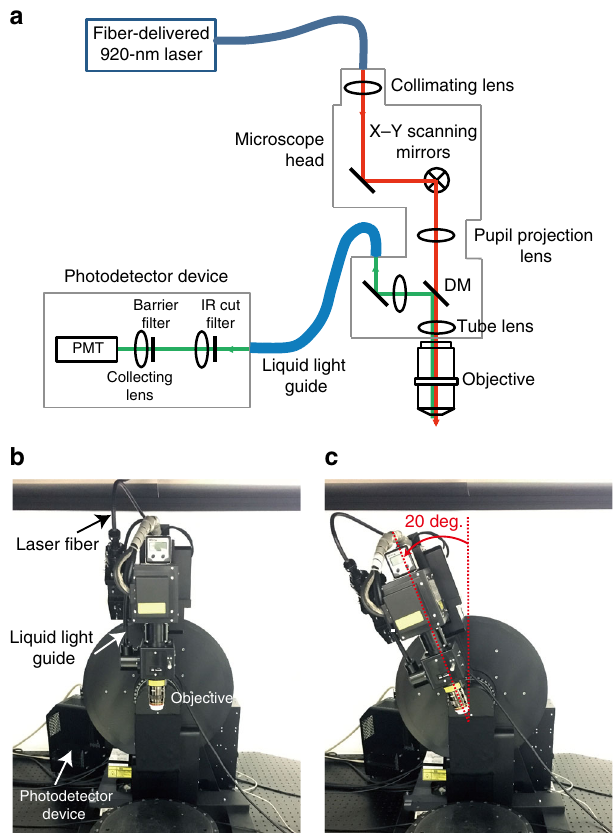
Fig. 6 Overview of the two-photon microscope for head- fi xed marmosets. a Scheme of the optical pathway. The laser beam was directly introduced to the microscope head with x – y scanners. Thus, the wavefront of the laser at the exit of the objective was not affected by the tilt of the microscope